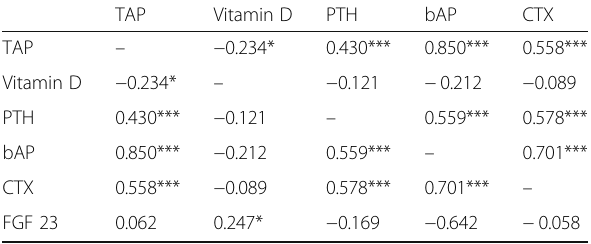
Table 3 Pearson ’ s correlation between biological parameters